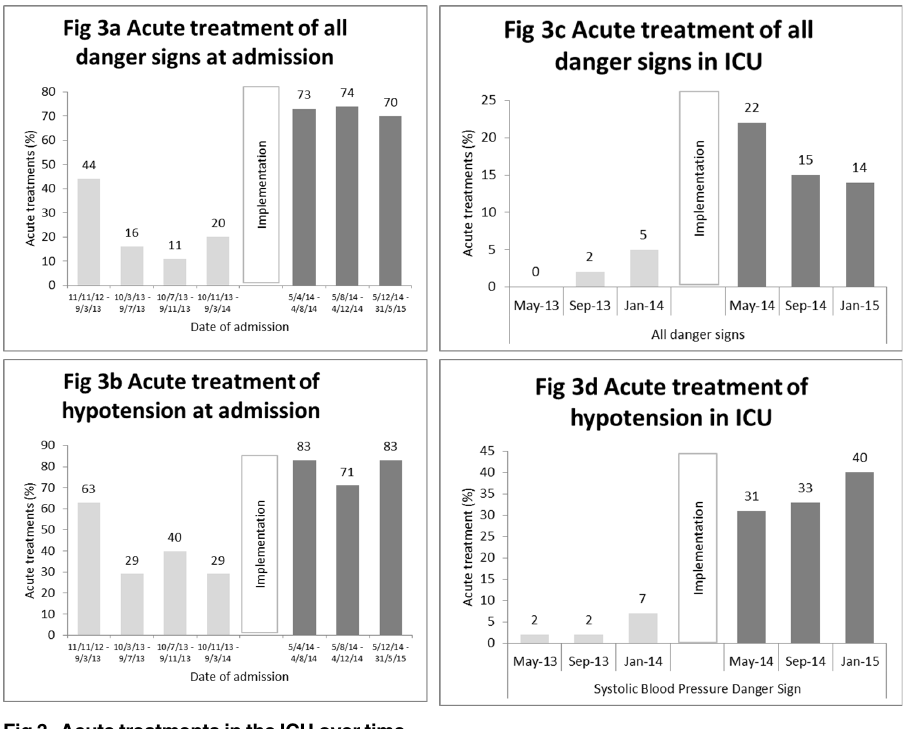
Fig 3. Acute treatments in the ICU over